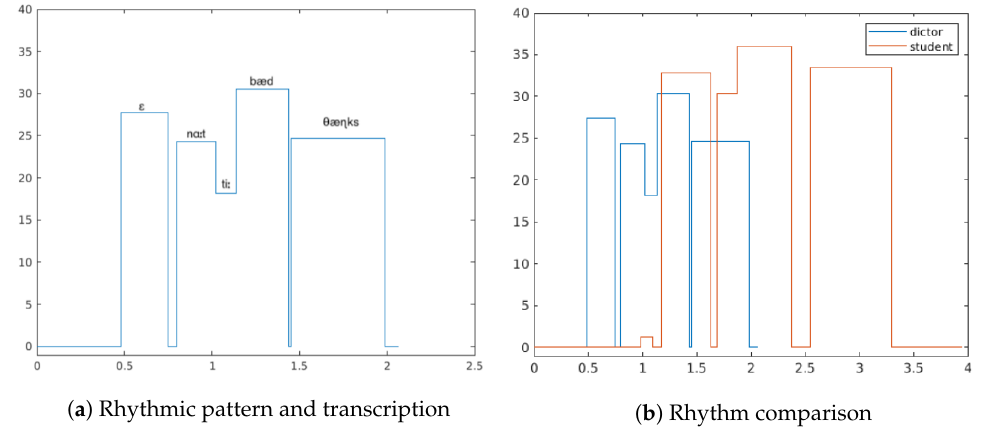
Figure 4. Visual feedback on rhythm is produced with joint representation of phonetic transcription and energy/duration rectangular pattern ( a ). Model and learner patterns can be obtained and shown together ( b ). In this case, both transcriptions are not shown to eliminate text